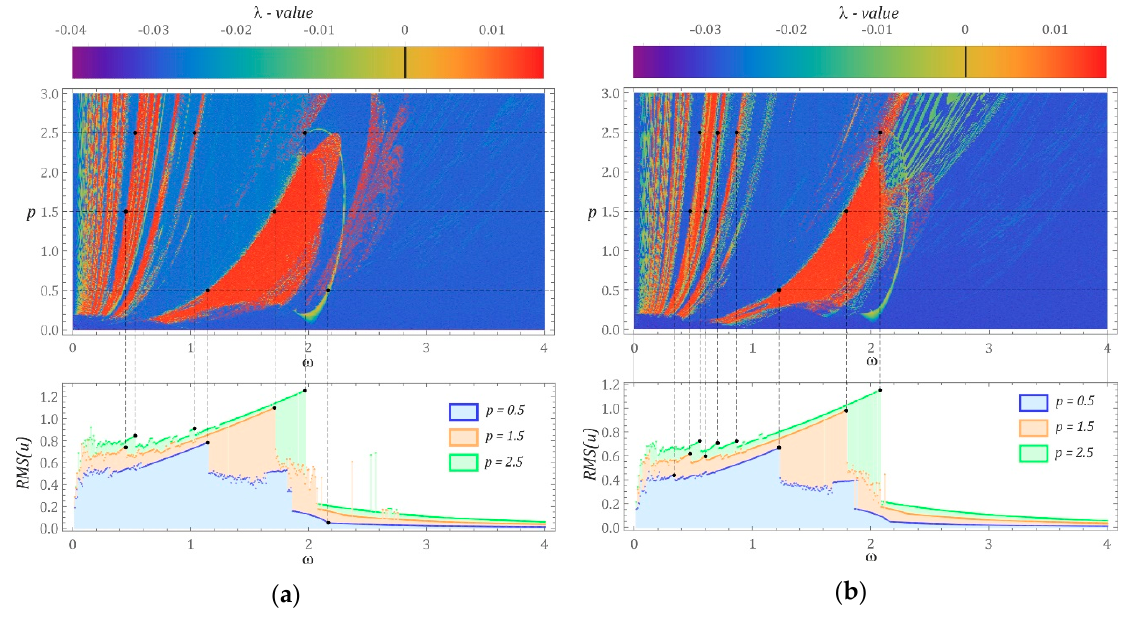
Figure 2. Influence of the parameter d and damping on the distribution of the largest Lyapunov exponent: ( a ) d = 0 , ( b ) d = 0.3 with nodal initial conditions.